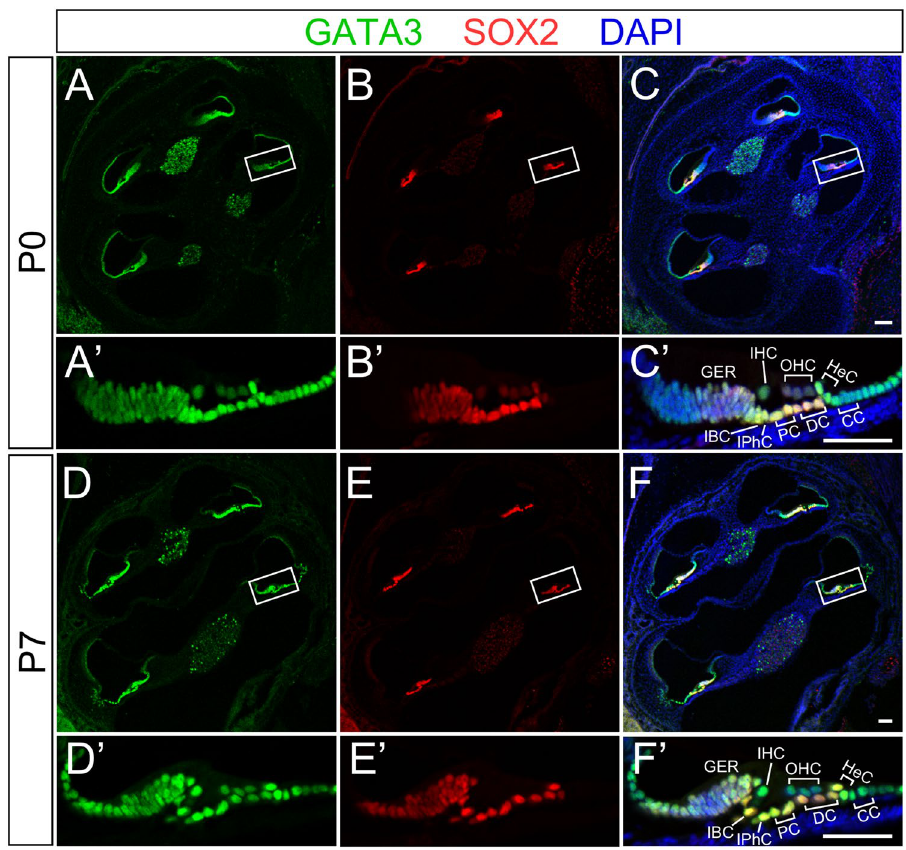
(green) and SOX2 (red) at P0 ( A – C , A ’– C ′ ) and P7 ( D – F , D ′ – F ′ ) shows that GATA3 is expressed in all hair cells and SOX2 + supporting cells during neonatal cochlear development. GER greater epithelium ridge, IBC inner border cell, IPhC inner phalangeal cell, PC pillar cells, DC Deiters’ cells, HeC Hensen’s cells, CC Claudius’ cells, IHC inner hair cell, OHC outer hair cells. Scale bars equal to 100 μm in ( A – F ) and 50 μm in ( A ′ – F ′